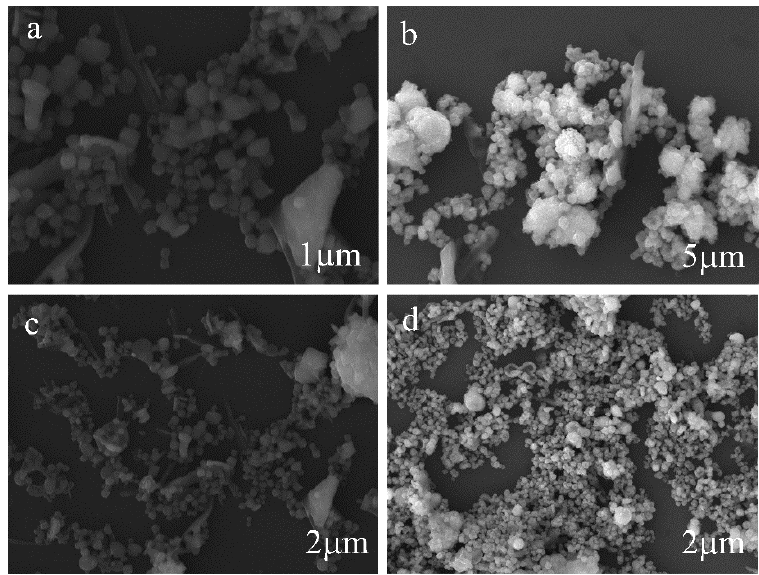
Figure 10. SEM images of ( a , c ) MIL-101(Fe) and ( b , d ) MIL-101(Fe)@Ag (Ag 0.0127